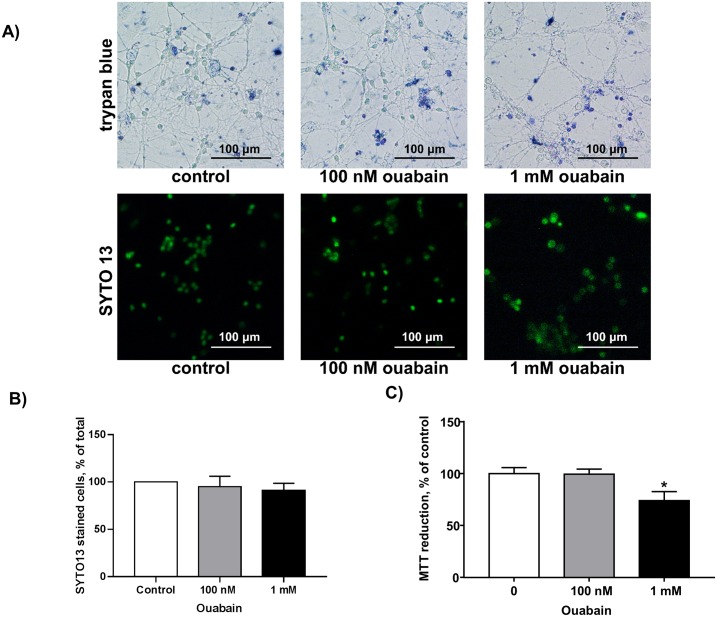
Estimation of viability of rat cerebellum granule cells by trypan blue staining and SYTO13 (A,B) and MTT reduction assay (C).A) Representative micrographs of control cells and cells exposed to 100 nM and 1 mM ouabain for 3 h. Bars = 100 μm. B) Percentage of SYTO 13-stained control cells and cells exposed to 100 nM and 1 mM ouabain for 3 h. C) MTT reduction assay of control cells and cells exposed to 100 nM and 1 mM ouabain for 3 h. Means ± SD for 4 (B) and 8 (C) independent experiments are shown. *—p<0.05.